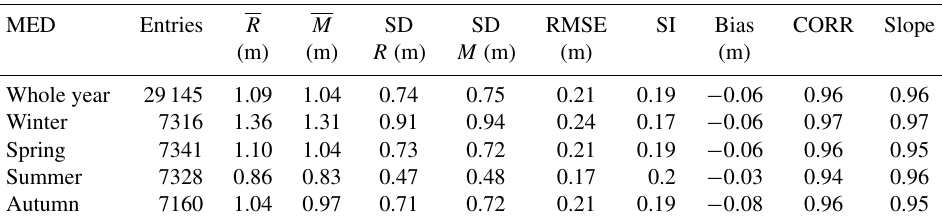
Table 4. Med-waves H s evaluation against satellite H s (Jason-2 and SARAL), for the full Mediterranean Sea, for a 1-year period (2014) and seasonally.